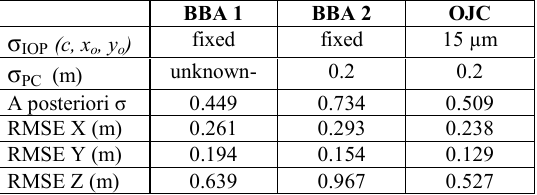
Table 10. Results for aerial images of band 23 with IOPs of band 22 from terrestrial calibration: a posteriori sigma and RMSE in the check points coordinates. .